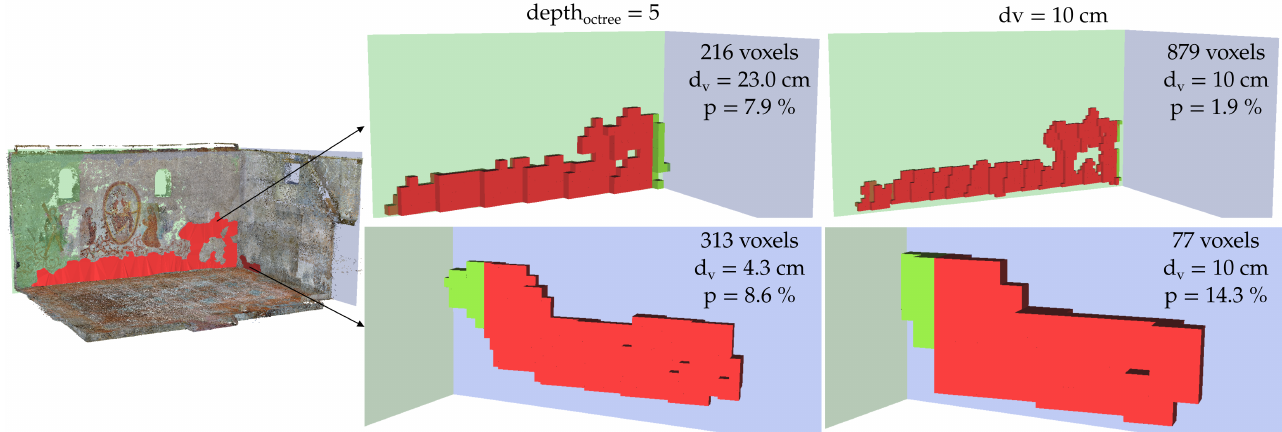
Figure 7. Three-dimensional views with wall elements and two exemplary 3D annotations from the case study dataset showing the voxel percentage to non-corresponding building elements: (green) assigned voxels and (red) not assigned voxels for octree based or defined voxel sizes with d min =